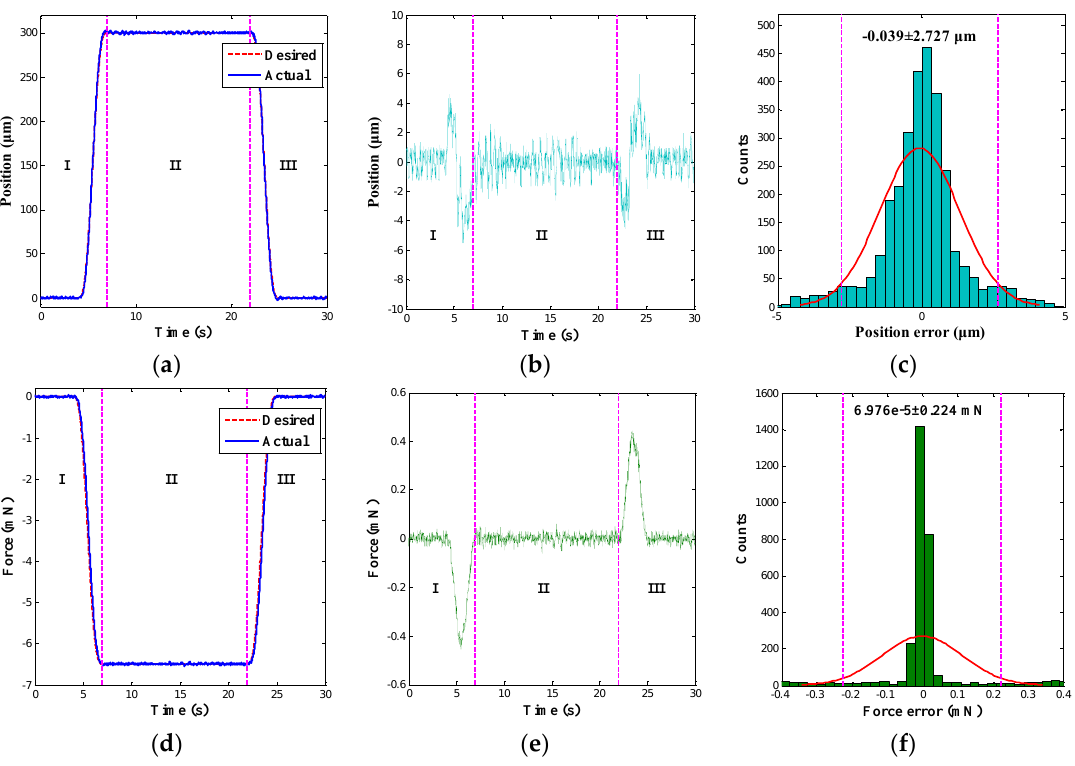
Figure 12. Hybrid position/force control results of a cycloid trajectory. ( a ) Position tracking result; ( b ) Position tracking error; ( c ) Histogram of position tracking error; ( d ) Force tracking result; ( e ) Force tracking error; and ( f ) Histogram of force tracking error.